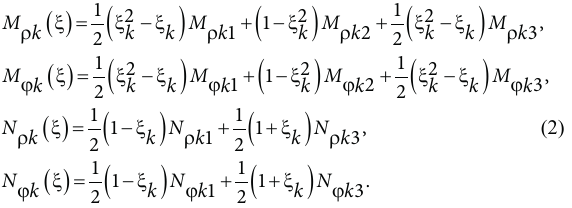
Fig 3. Forces acting on the main node of the